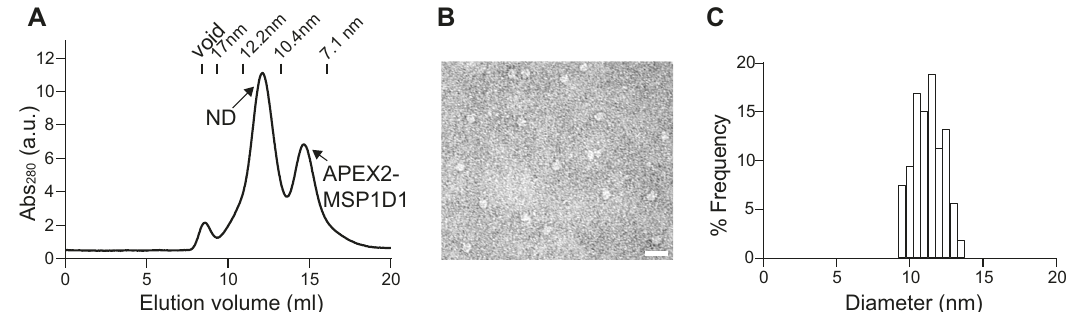
Fig. 4 Characterization of APEX2-MSP1D1 nanodiscs. A Reconstituted nanodiscs were separated by SEC using superdex 200 10/300. B Representative negative stain EM images of the fractions corresponding to NDs from SEC ( A ). Scale bar: 20 nm. C Quanti fi cation of ND sizes from negative stain EM images ( n =